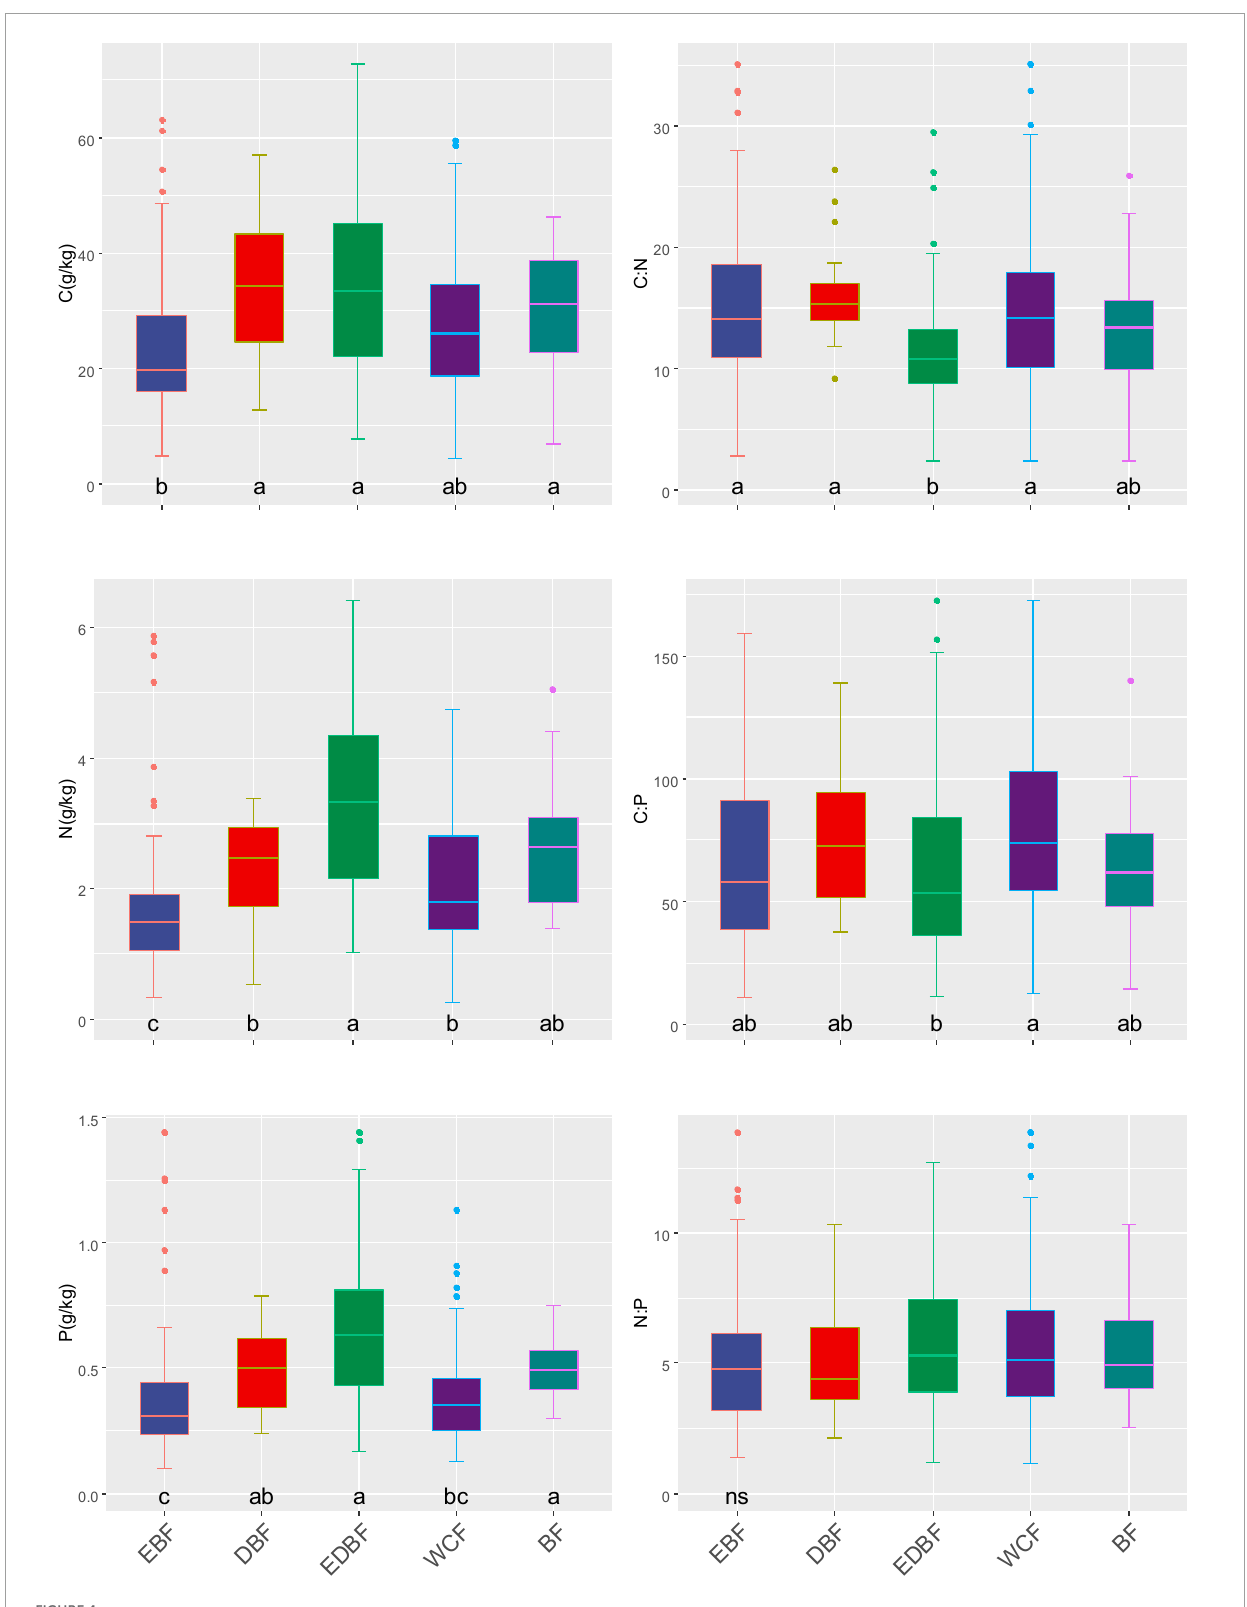
FIGURE4 The soil C, N, and P stoichiometric properties respectively under different vegetation of the main forests in Guangxi. EBF, DBF, EDBF, WCF, BF represent evergreen broadleaf forest, deciduous broadleaf forest, mixed evergreen and deciduous broadleaf forest, warm coniferous forest, and bamboo forest. Different lower letters indicate significant differences in soil C, N, and P and their stoichiometric properties among the five forest types.